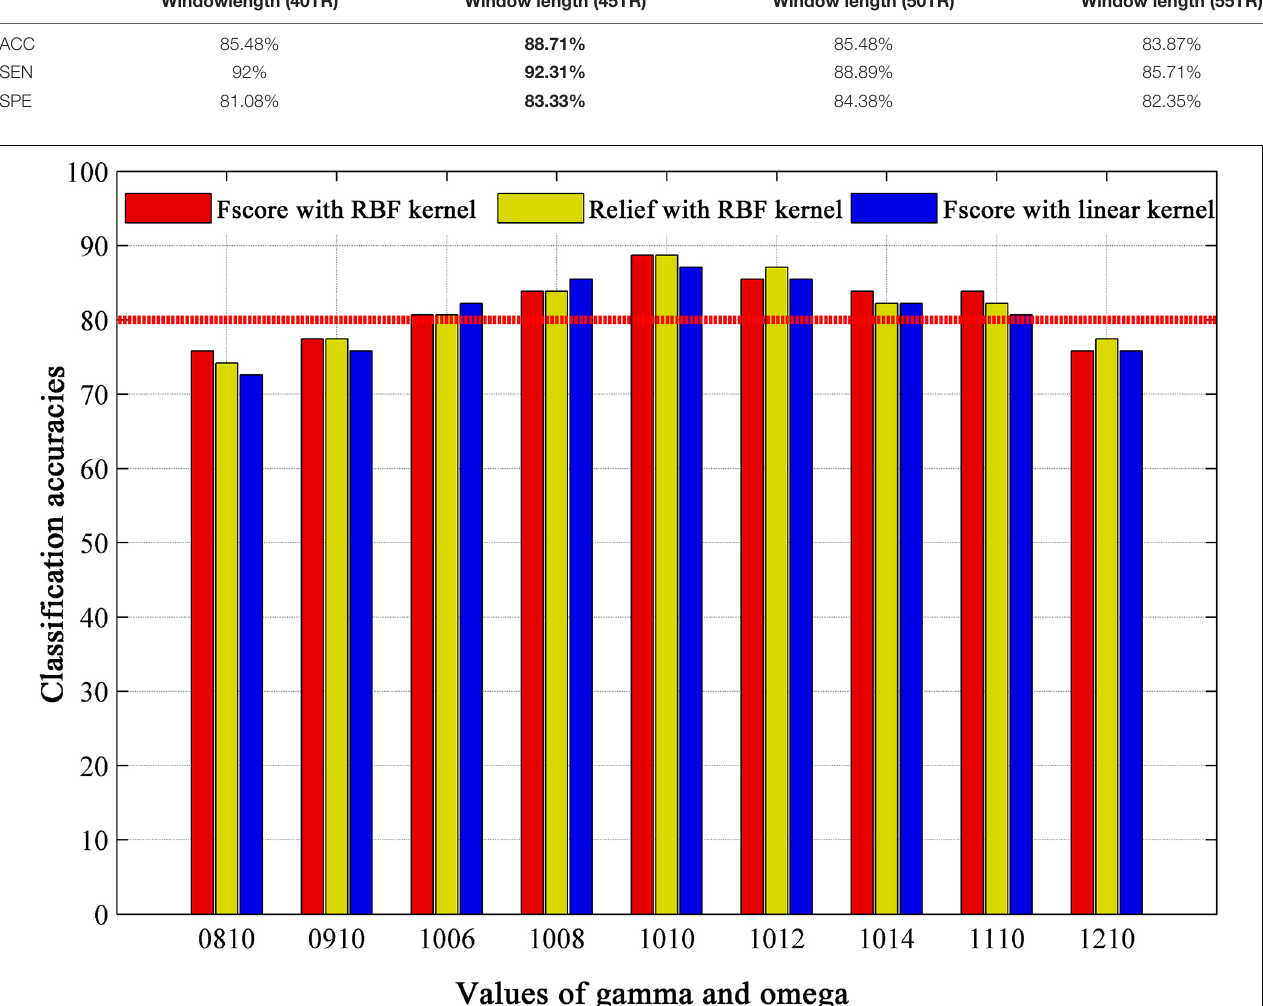
TABLE 5 | The classification results with different window length.